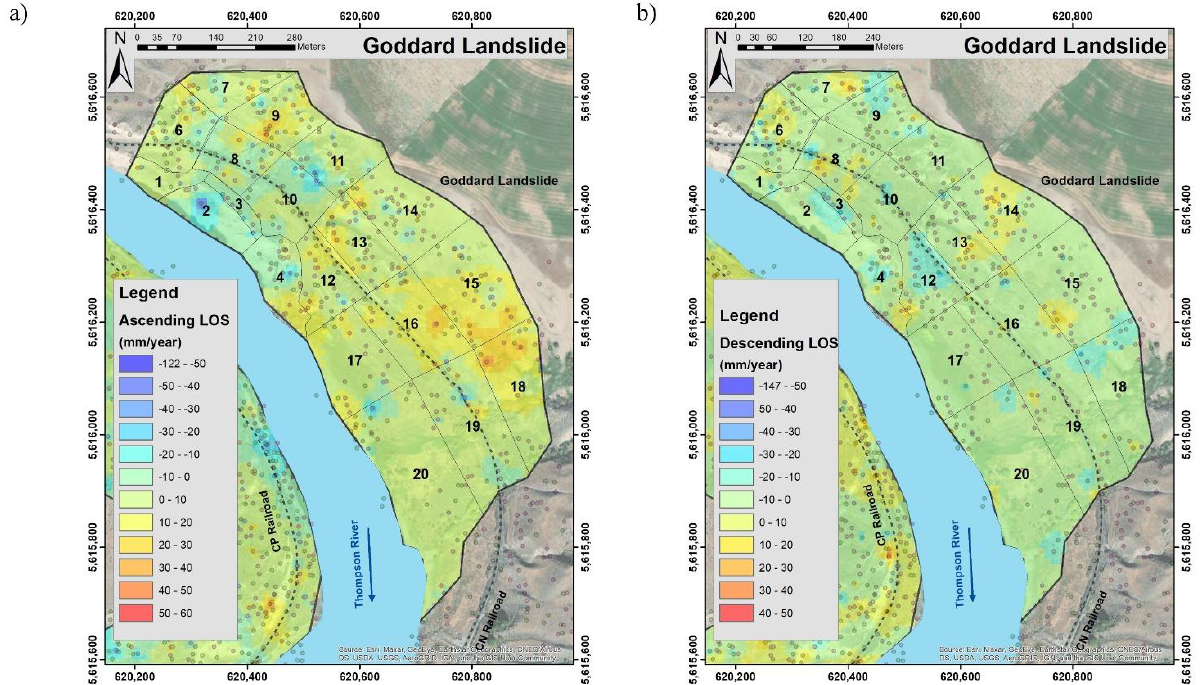
Figure 4. The cumulative LOS changes at the end of the selected timeline for Goddard landslide for ( a ) Sentinel ascending and ( b ) Sentinel descending orbits.